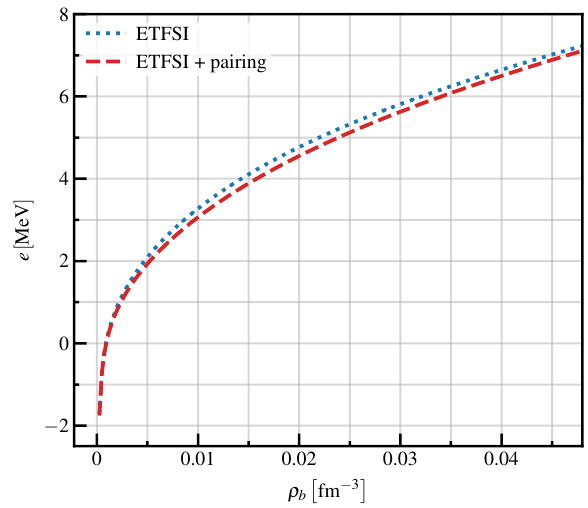
Figure 6. Energy per particle, e , for the inner crust, using the SLy4 functional. The result for ETFSI is shown by the blue dotted line, and the red dashed line shows the result with neutron and proton pairing included (using the strong